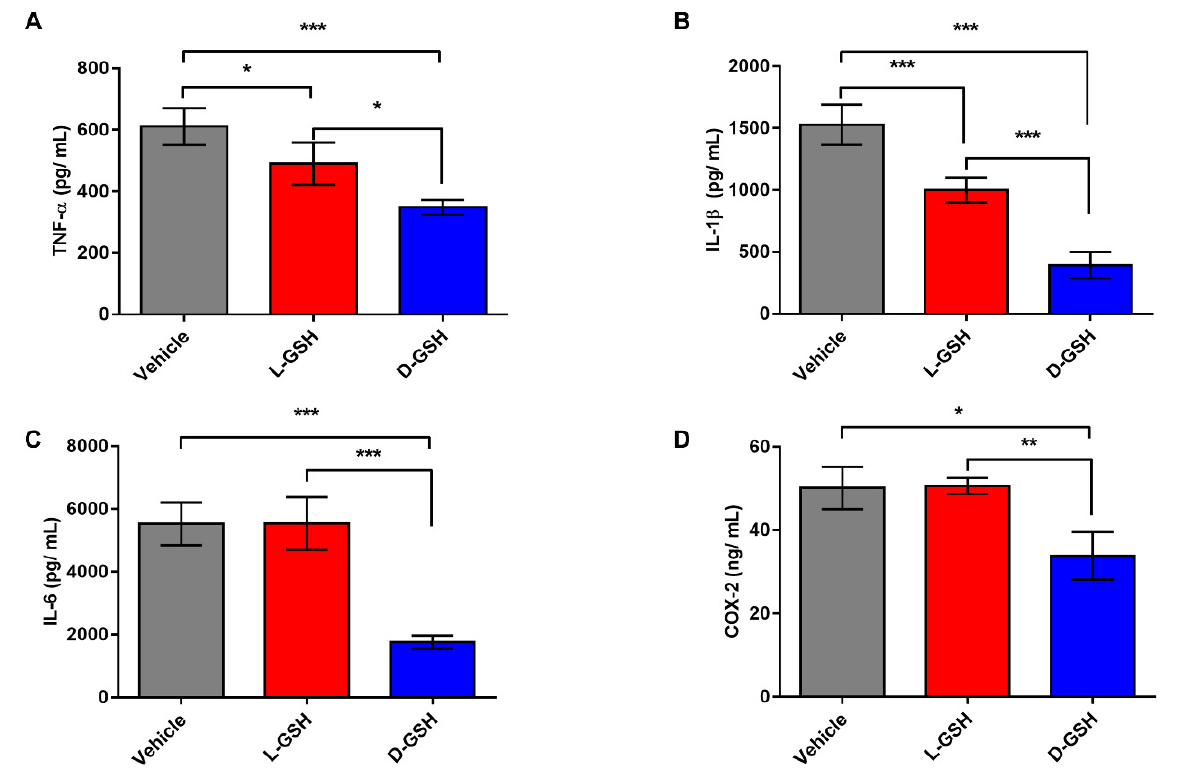
Figure 2. The protein secretion levels in the injured spinal cord segments of the vehicle, L-GSH, and D-GSH groups after SCI. Quantification of ( A ) Tumor necrosis factor- α (TNF- α ), ( B ) interleukin (IL)-1 β , ( C ) IL-6, and ( D ) cyclooxygenase-2 (COX-2). Results are the mean ± SEM; * p < 0.05, ** p < 0.01, and *** p < 0.001; one-way ANOVA with Tukey post hoc test.